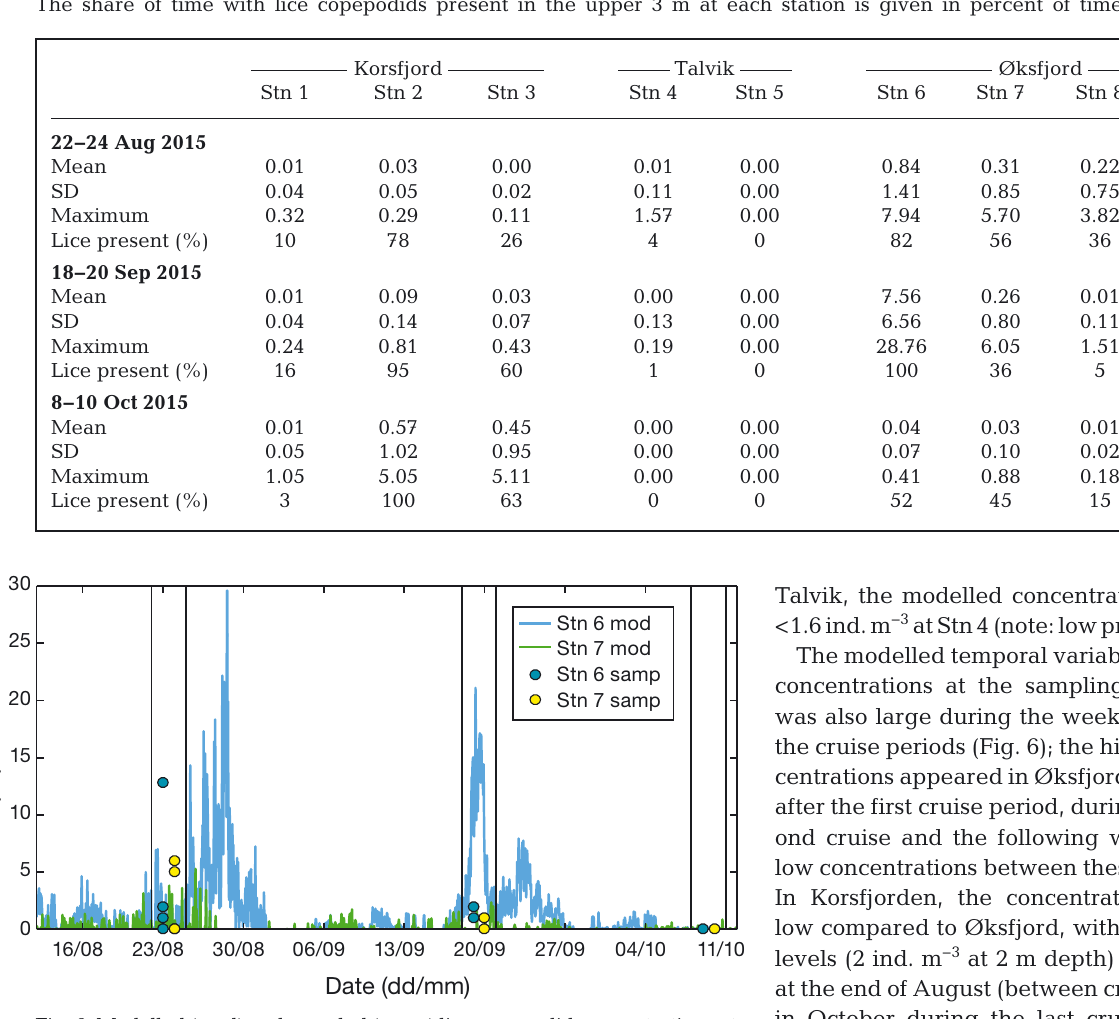
Table 3. Modelled concentrations of salmon lice copepodids (ind. m −3 ) in grid cells representing the sampling stations in Altafjorden in 2015. Mean and maximum concentrations (n = 219) are given for the three 73 h periods representing the